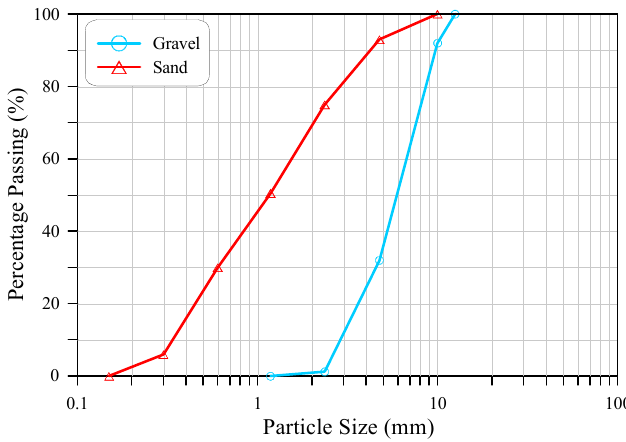
Figure 1. Sieve analysis of the adopted fine and coarse aggregates.